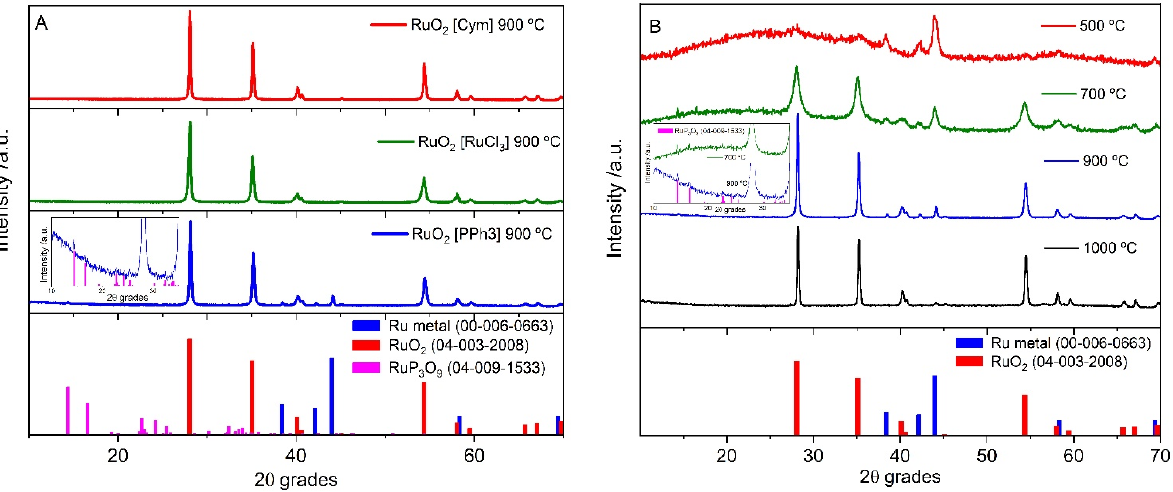
Figure 4. ( A ) XRD patterns of the calcined materials obtained at 900 °C: RuO 2 [RuCl 3 ], RuO 2 [Cym], and RuO 2 [PPh 3 ]. ( B ) XRD patterns of [RuCl 2 (PPh 3 ) 3 ] calcined at different temperatures: 500 °C, 700 °C, 900 °C, and 1000 °C.